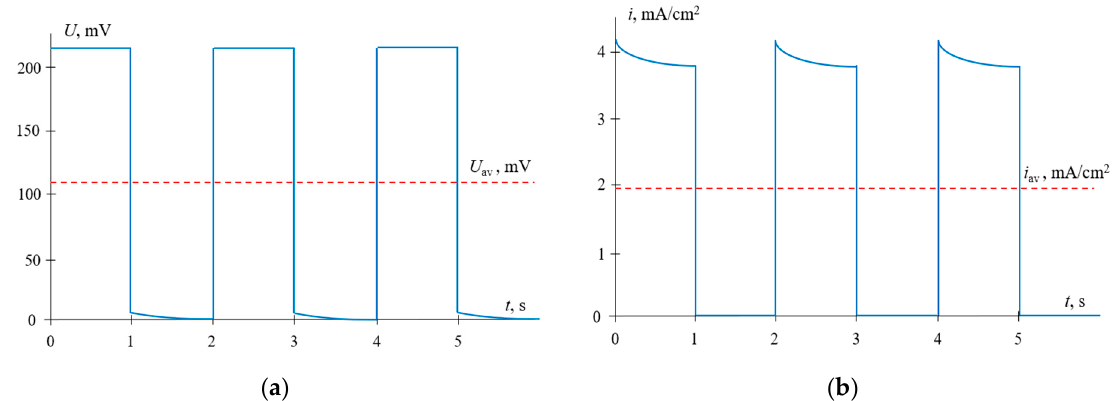
Figure 6. Time dependences of the voltage ( a ) and current density ( b ) for PEF mode, when voltage pulses are applied. The results of calculations at α = 0.5, f = 0.5 Hz and U av = 111 mV ( i = 0.3 i lim in CC mode).